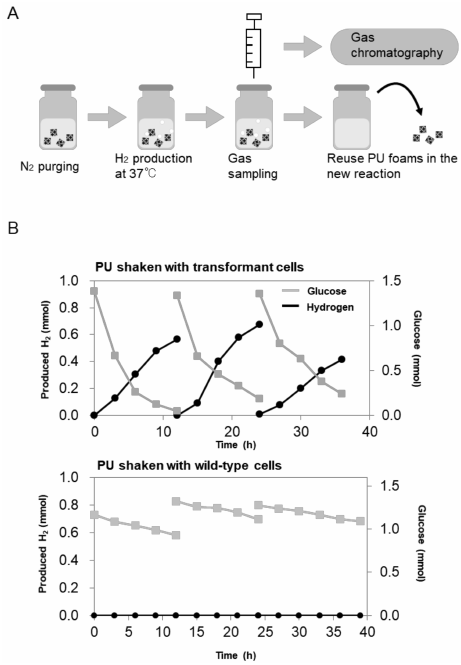
Figure 4. Repetitive hydrogen production by immobilized E. aerogenes in batch reactions. ( A ) Repetitive batch reactions utilizing polyurethane foams shaken with the transformant or wild-type cells; ( B ) hydrogen yields (black) and glucose consumptions (gray) measured during the three repetitive batches.